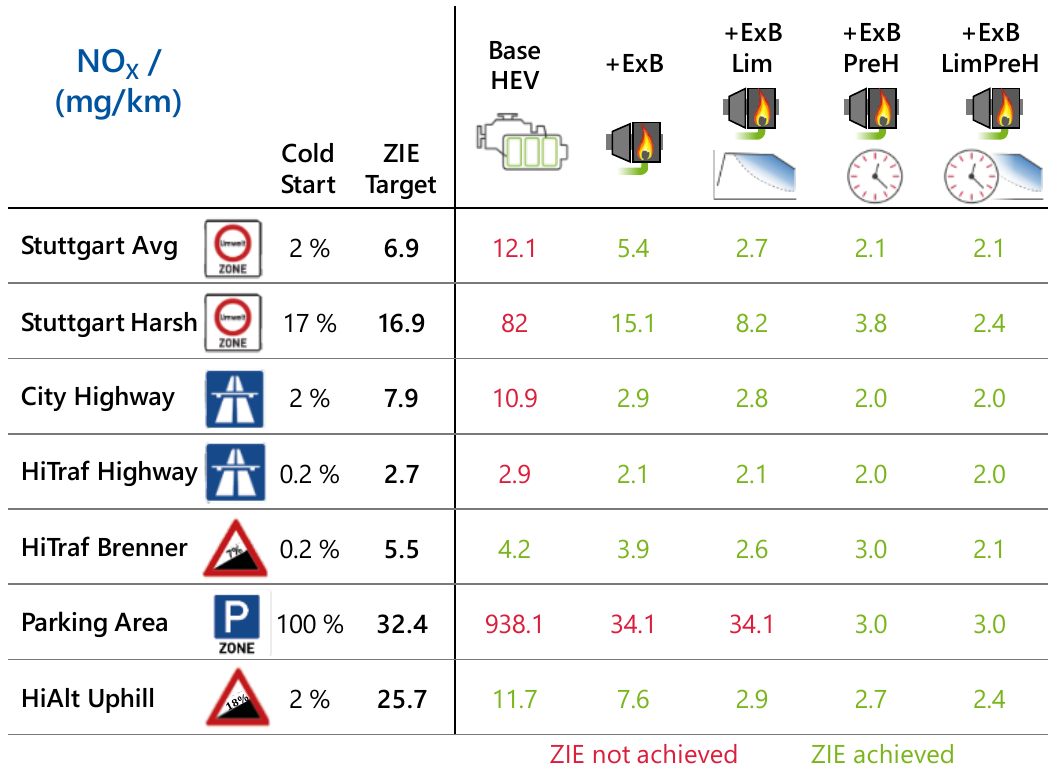
Figure 17. Exhaust fuel burner technology packages under Zero-Impact Emissions test